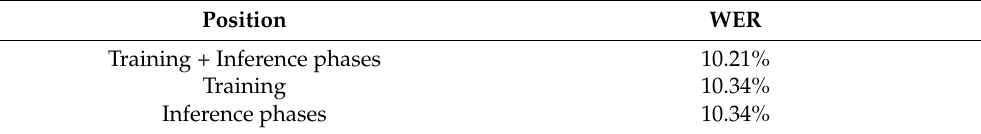
Table 7. Experiments using a penalty factor with a value of 1.1 in the training or inference phase, and their combination.